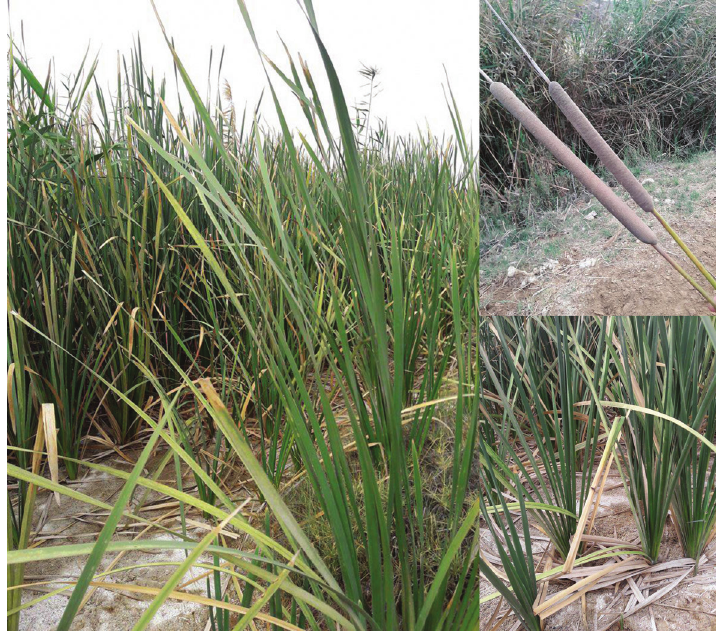
Figure 7. Typha elephantina Roxb. in El-Baida Lake, Wadi Natrun (Egypt). Plants living in their natural habitat and spikes. Pictures by M. Abdelaal.